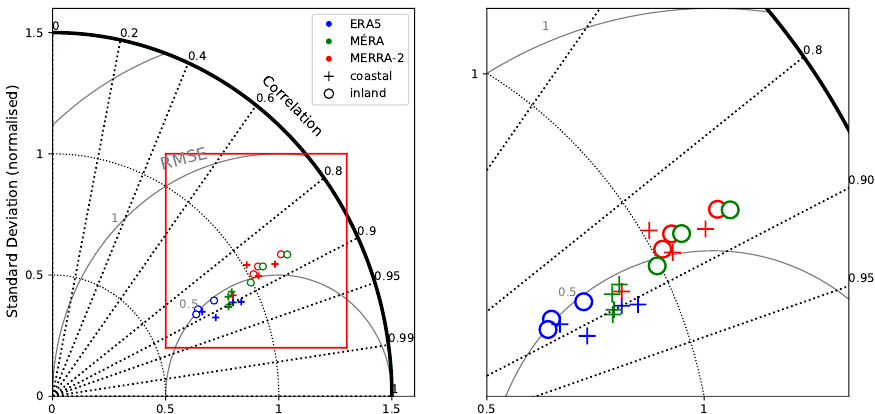
Figure 5. Mean 10 m wind speed at each hour at the coastal station Belmullet for winter (DJF), spring (MAM), summer (JJA), and autumn (SON) for ERA5 ( blue ), MÉRA ( green ), and MERRA-2 ( red ) compared with observations ( black ).